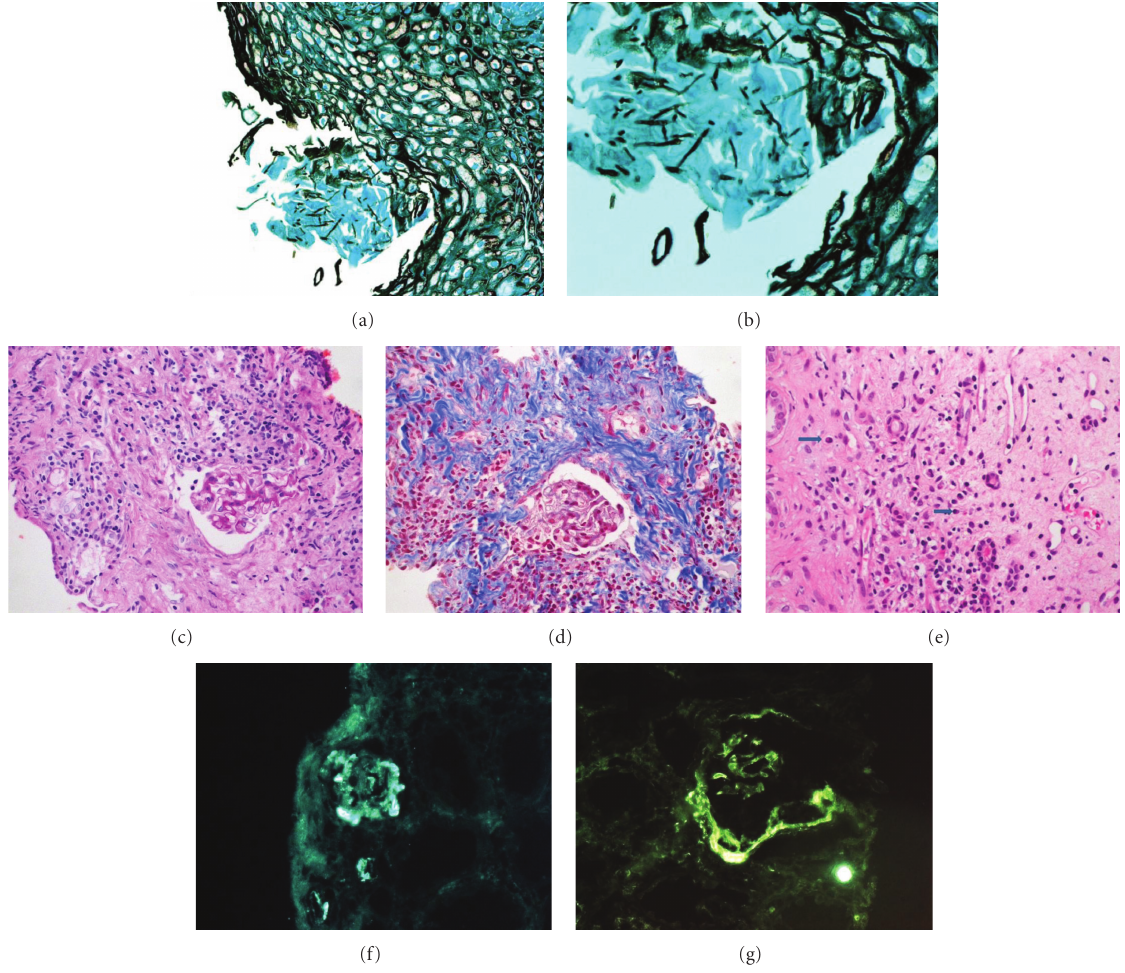
Figure 2: Superficial esophageal mucosa ((a),(b)) invaded by candidal psudohyphae. Grocott-Methenamine silver (original magnification 200x (a)/400x (b)). Renal biopsy ((c), (d), (e)) shows ischemic glomerular tuft with thick and wrinkled basement membrane (PAS stain 40x) (c) and extensive tubular loss with replacement by fibrosis (Masson trichrome stain 40x) (d). The interstitium shows lymphocytes